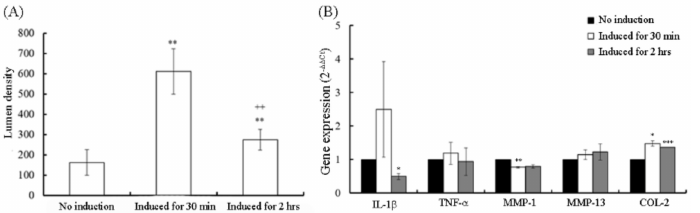
Figure 1. The induction of osteoarthritis by H 2 O 2 in porcine chondrocytes. ( A ) The level of oxygen- derived free radicals was represented by the level of lumen density. The level of lumen density increased significantly when the chondrocytes were treated with H 2 O 2 for 30 min and 2 h. ** p < 0.01 compared with no induction. ++ p < 0.01 compared with 30 min induction. ( B ) The expressions of IL-1 β , TNF- α , and COL2A1 were higher when the chondrocytes were induced by H 2 O 2 for 30 min (white bars) than for 2 h (gray bars). Gene expression with no induction is shown in black bars. * p < 0.05, ** p < 0.01, and *** p < 0.001 compared with no